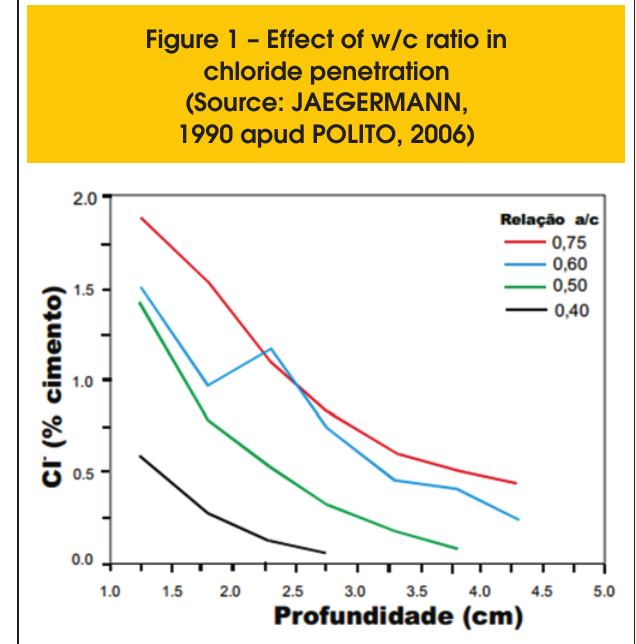
Figure 1 – Effect of w/c ratio